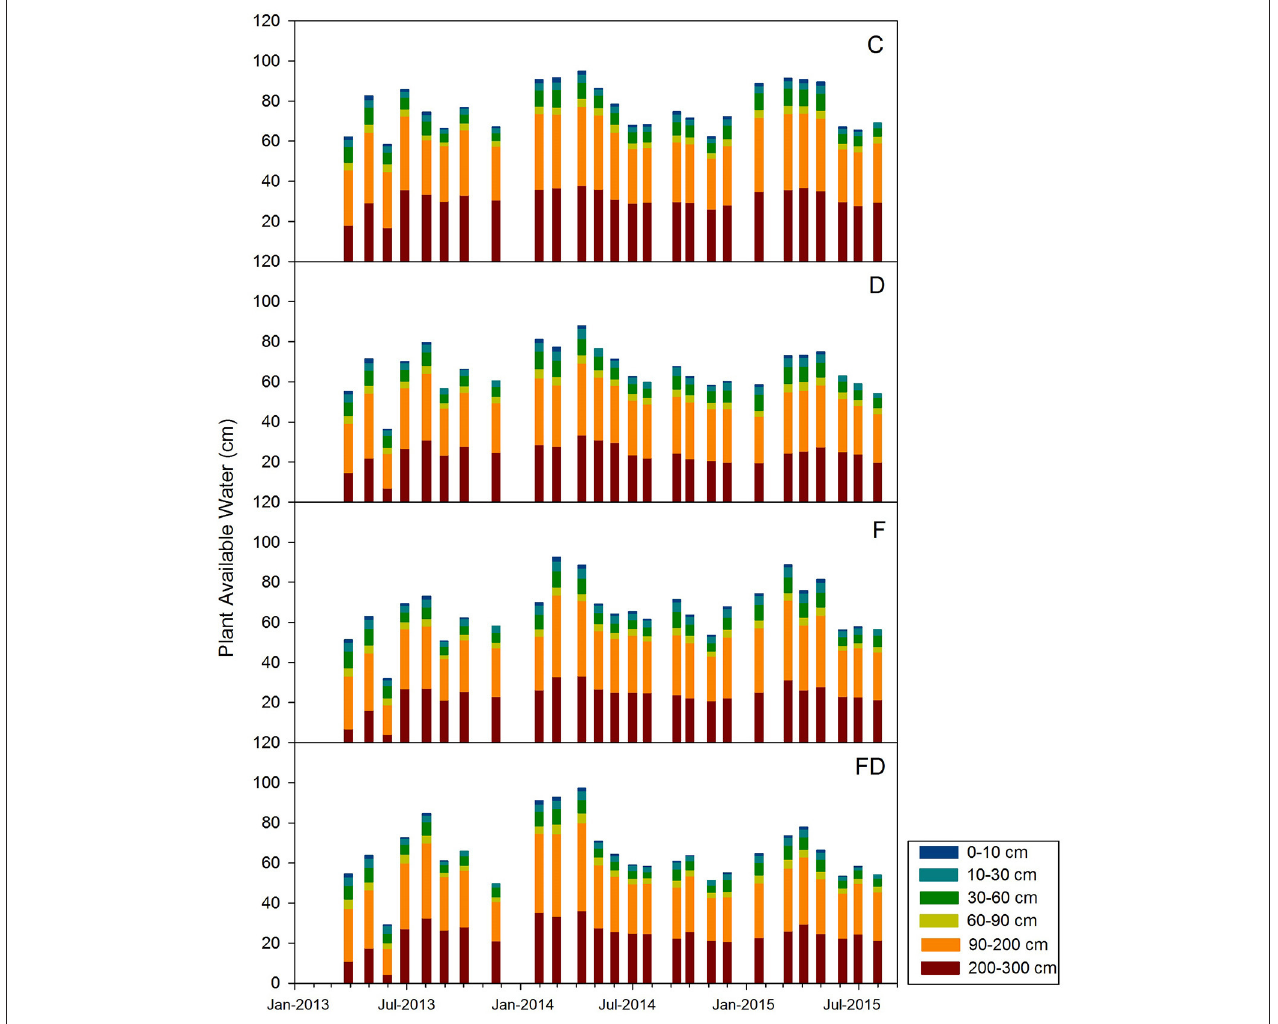
FIGURE 7 | Seasonal trends in plant available water for control (C), fertilization (F), throughfall reduction (D) and combined treatment of FD for March 2013 to July 2015. Stacked bars represent plant available water storage of 0–0.1, 0.1–0.3, 0.3–0.6, 0.6–0.9, 0.9–2.0, and 2.0–3.0